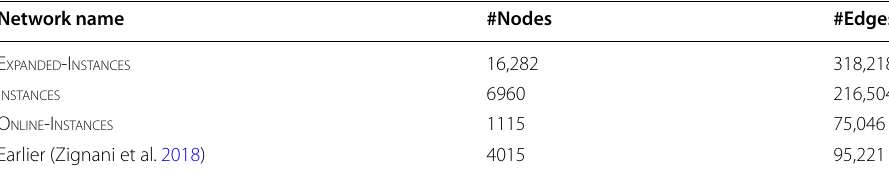
Table 2 Networks created from our collected dataset, and comparison with the earlier state-of-the- art